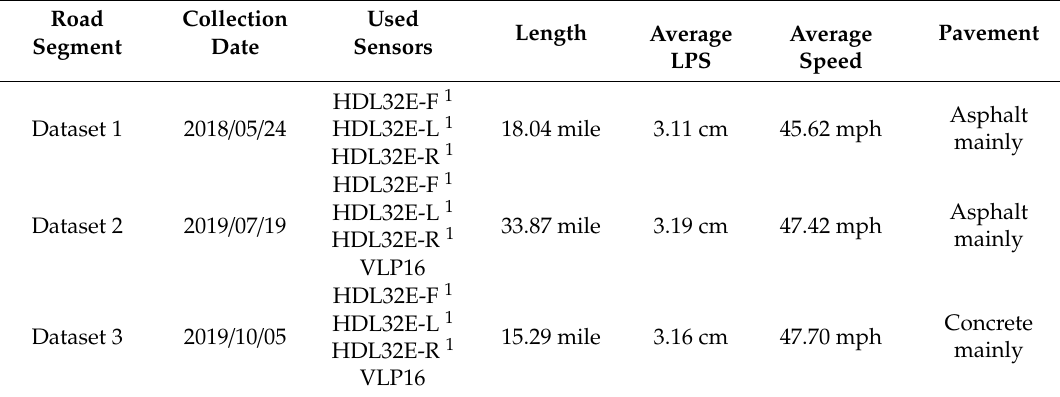
Table 2. Description of the three LiDAR-based mobile mapping systems (MMS) point clouds.